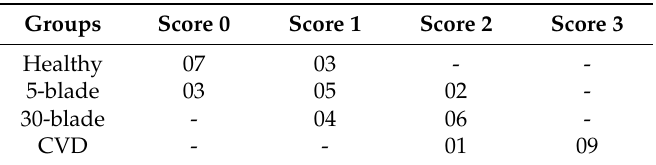
Figure 2. Profilometry images. ( A ) The five-bladed group exhibits a curve profile with higher polishing. ( B ) The 30-bladed tungsten carbide group showed a flat surface with abrupt changes. ( C ) The diamond group (CVD) showed greater amount of pores and irregular contour. Table 3. Evaluation of SEM images.